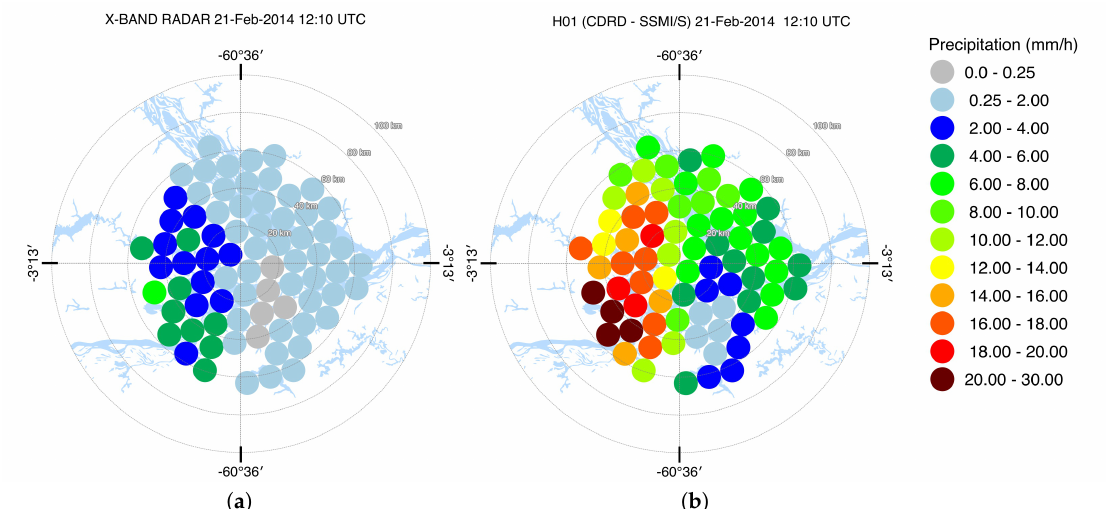
Figure 11. ( a ) Rain rate from radar upscaled to the satellite grid and ( b ) H01 rain rate retrieval in Manaus on 21 February 2014 at 12:10 UTC.